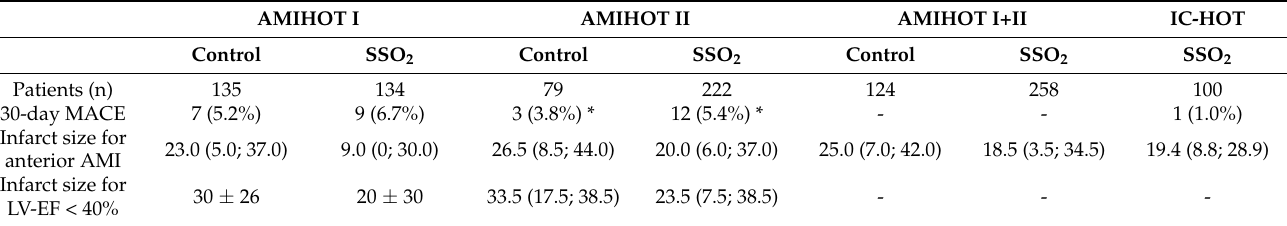
Table 3. Clinical findings from three randomized trials using SSO 2